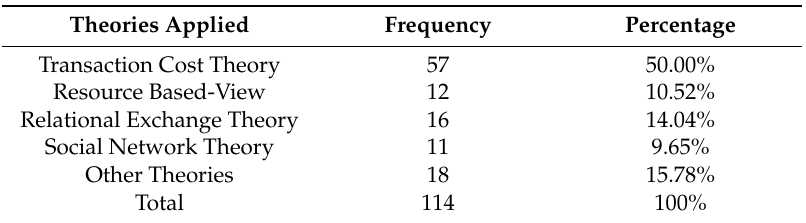
Table 5. The theories applied in the synthesized